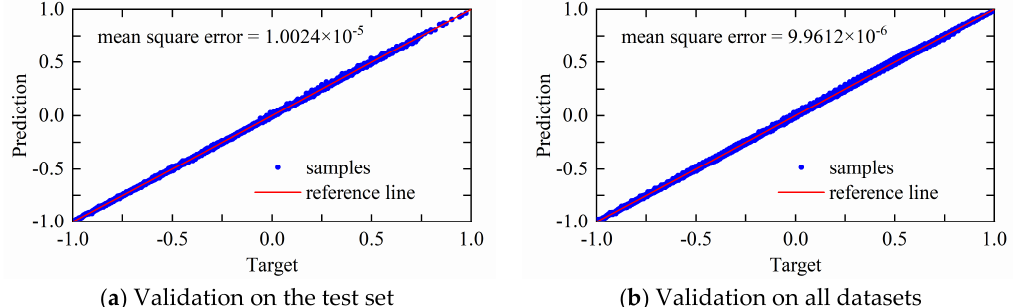
Figure 7. Validation of the trained artificial neural networks.